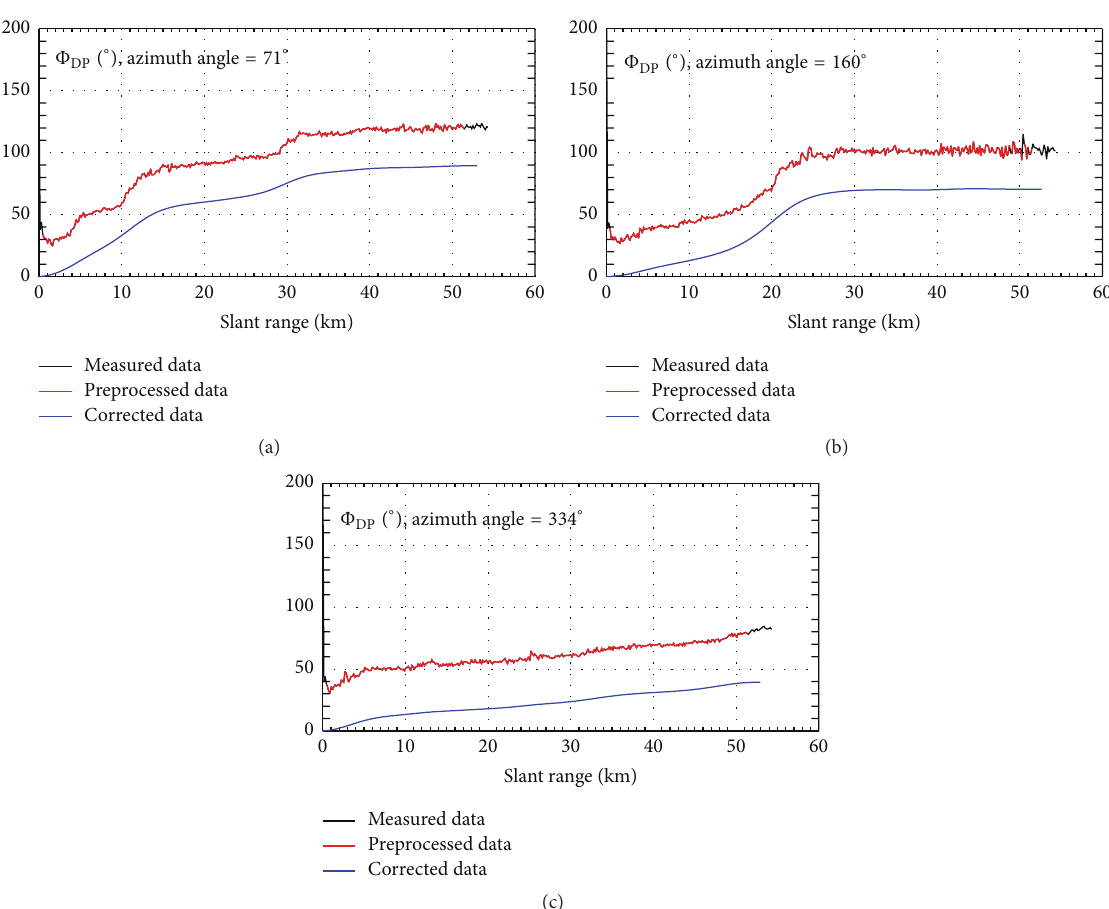
Figure 6: Range profiles of measured (black); 𝜌 threshold, isolated point removing (red); and FIR filter and offset adjusted (blue) Ψ HV at 71 ∘ (a), 160 ∘ (b), and 334 ∘ (c) azimuth angles of NIMS-XPOL for the case in Figure 5. estimation of Φ DP